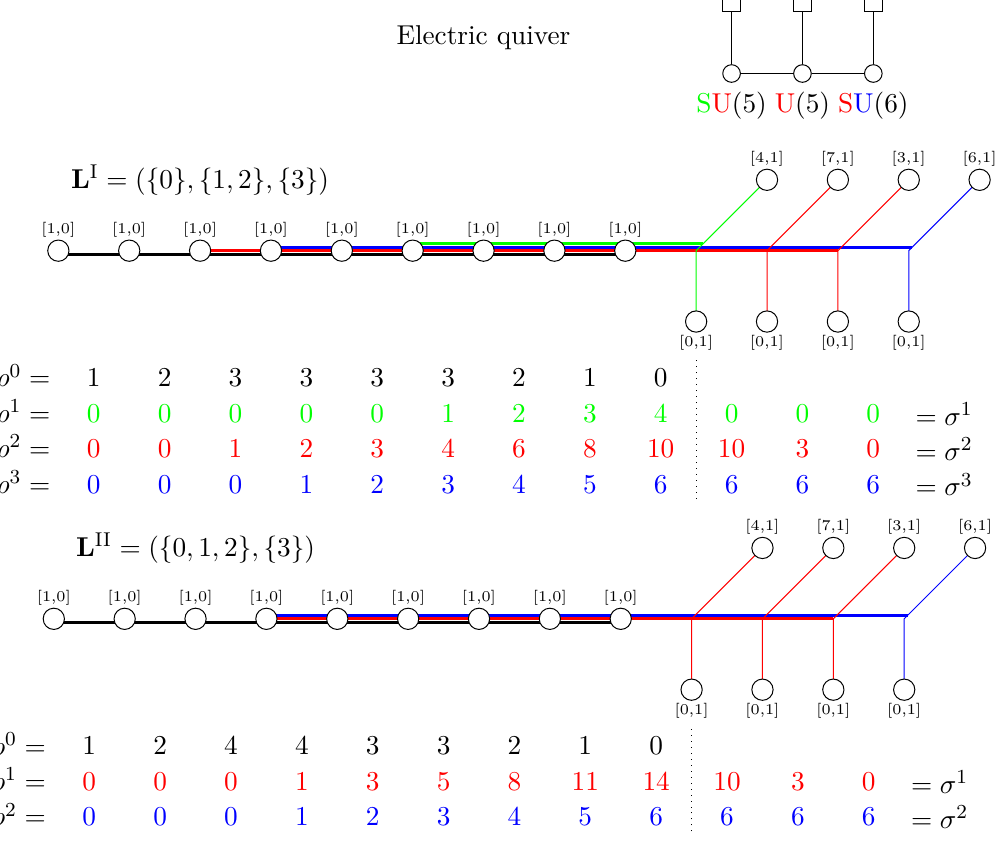
Figure 3 . Examples of two brane webs corresponding to two different admissible lockings L I and L II . The slopes of the branes of type [ p, 1] are not respected. Each thick line of a given color corresponds to a stack of D5 branes; the number of D5 branes in each stack is indicated below with a number of the same color. These number correspond to the lists ρ j and σ j computed in the algorithm (the dotted line shows the limit between ρ j and σ j ), for j = 1 , . . . , c running through the colors. The colors other than black denote the locking, while the various black stacks can move independently of each other in the x 7 , x 8 , x 9 direction. The list ρ 0 corresponds to the number of D5 branes in those stacks. The electric quiver is depicted on top, with a color code showing the top locking L ( s ) = L I